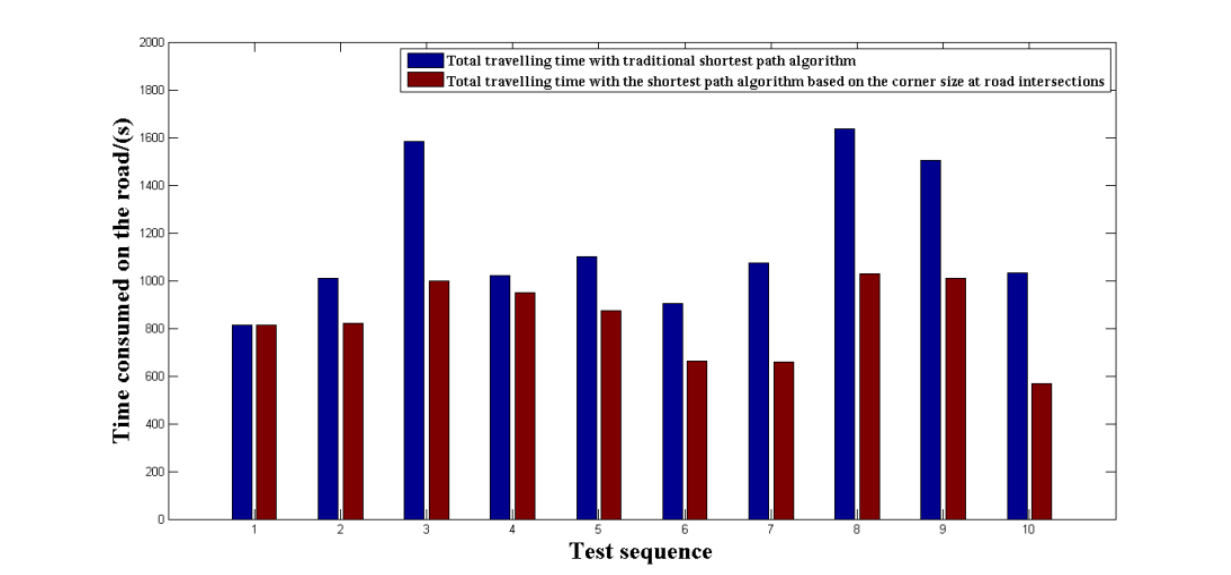
Figure 9. Total time spent by oversized trucks to pass through different routes with the traditional shortest path algorithm and the one based on the size of the corners.